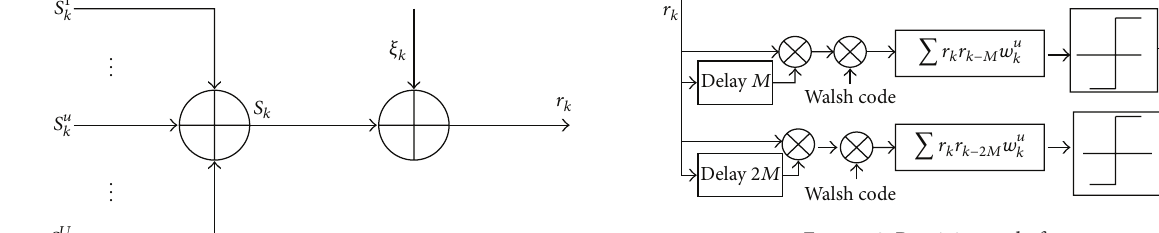
Figure 3: Receiving end of user 𝑢